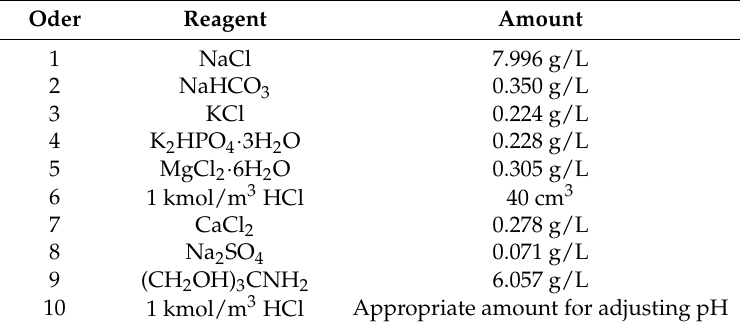
Table 2. Reagents used to prepare 1 L of the SBF solution (pH = 7.40)